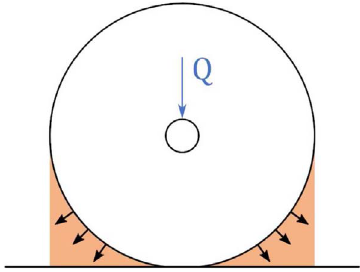
Figure 6. Diagram of the wheel compression under an arbitrary load Q . The movement of the wheel into the areas formed between the wheel and the fl oor overrides any effect a change in Poisson ’ s ratio may have on the